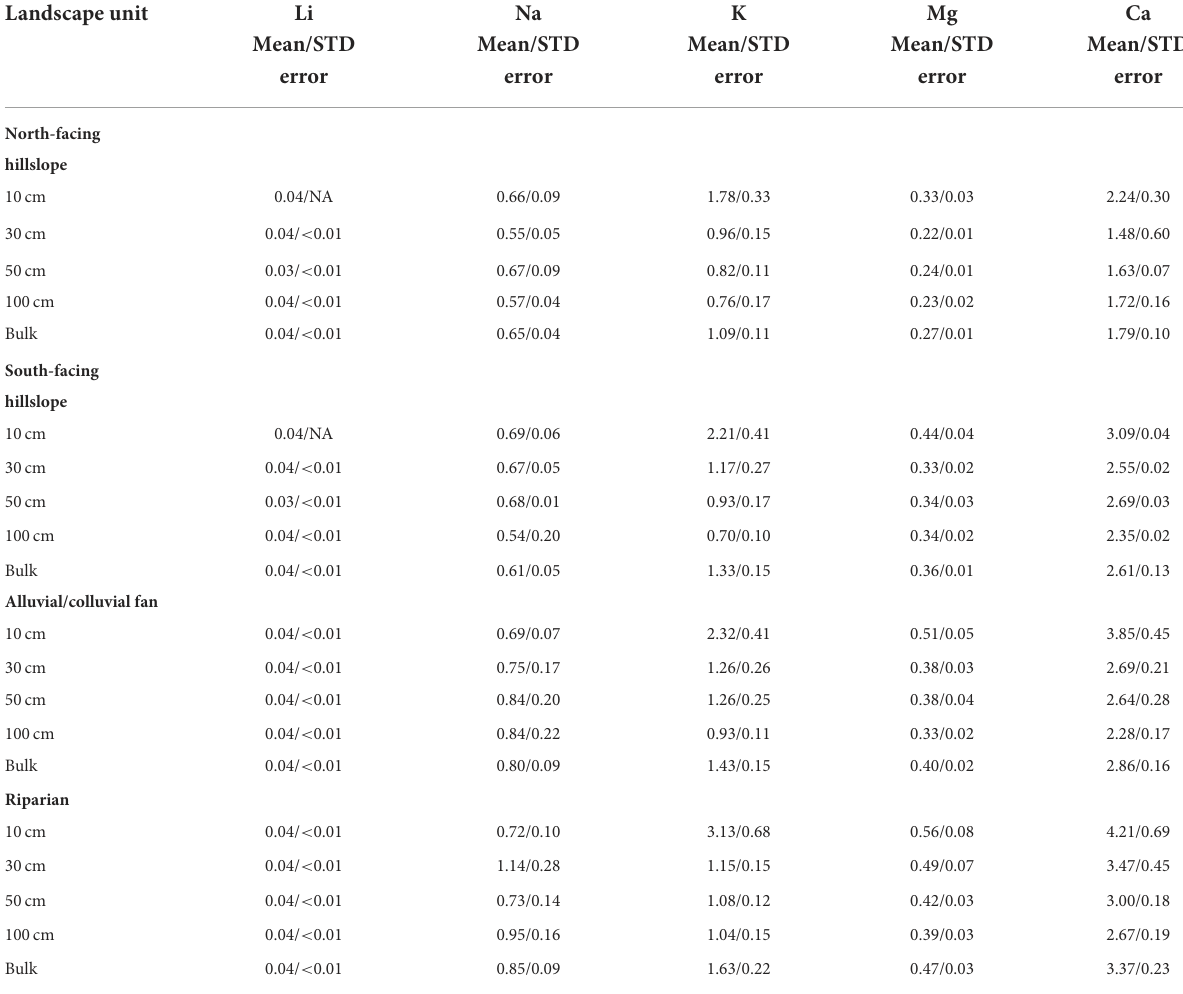
TABLE 2 Mean and standard error for each of the studied cation concentrations at each depth, and bulk, for every landscape unit. Landscape unit